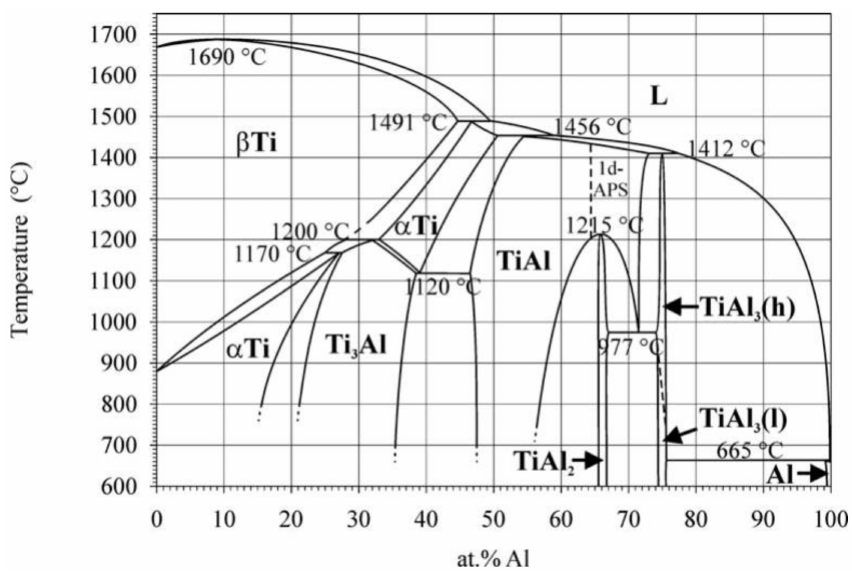
Figure 1. The phase diagram of the Ti-Al system